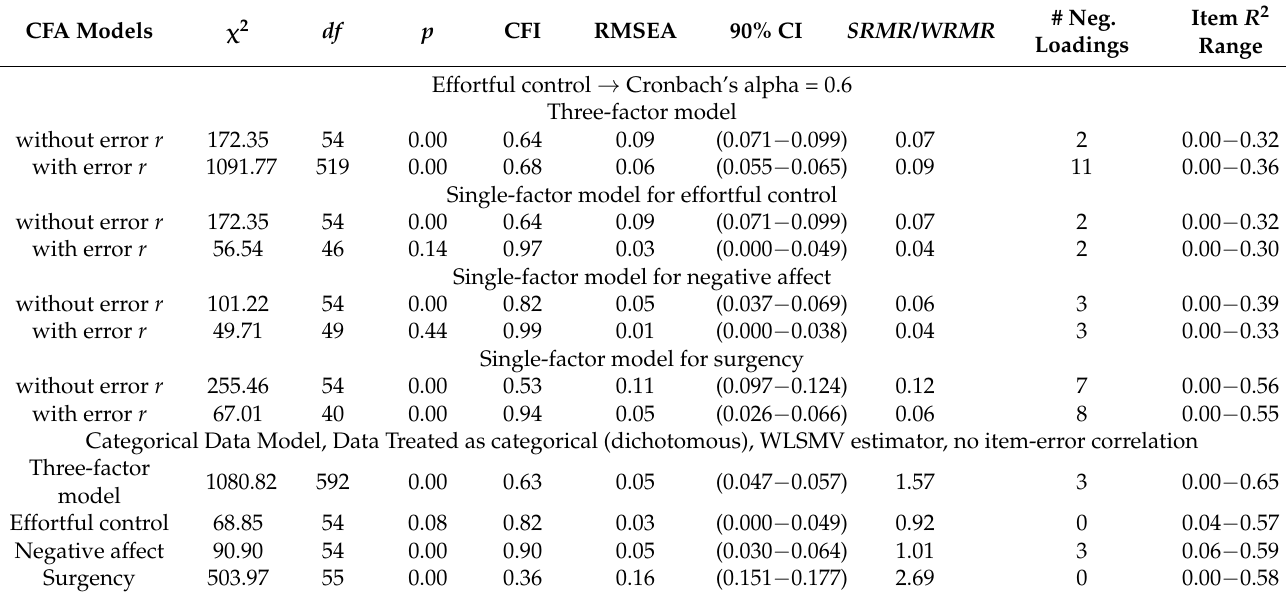
Table 3. Model-fit statistics for the CBQ-VSF ( N =